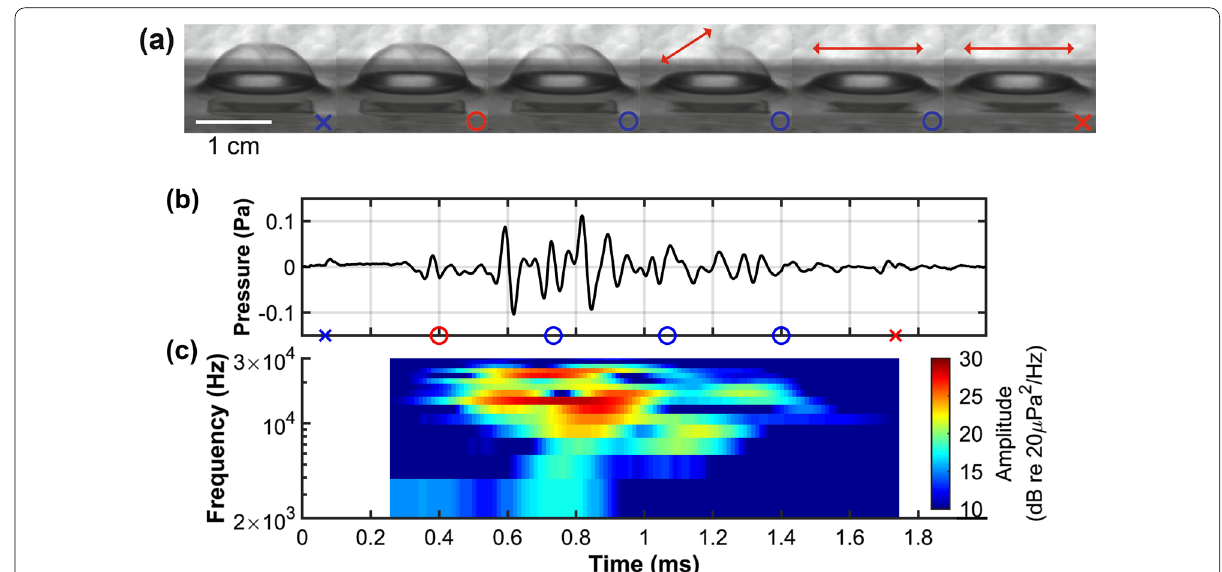
Fig. 5 An example of HF wave (case 3). V = 0.6 cm 3 hemispherical cap bubble bursts in a suspension of φ = 0.3 . a Time-lapse images (see Additional file 1: Movie 1). Blue × : before bursting, (cid:31) : after bursting, red × : film disappearance. Red arrows indicate the aperture. b Waveform (detrended, highpass filtered at 800 Hz). Markers correspond to the timing shown in ( a ) and are plotted at the end of the exposure time of each image. c Spectrogram of ( b ) using a 0.512 ms sliding window and a 0.5 ms